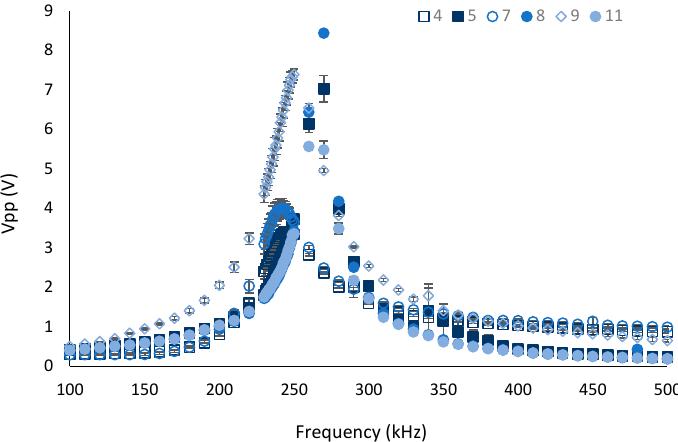
Figure 3. Vpp for different frequencies according to the pH value. Data include the repetitions per- formed for the different temperatures.